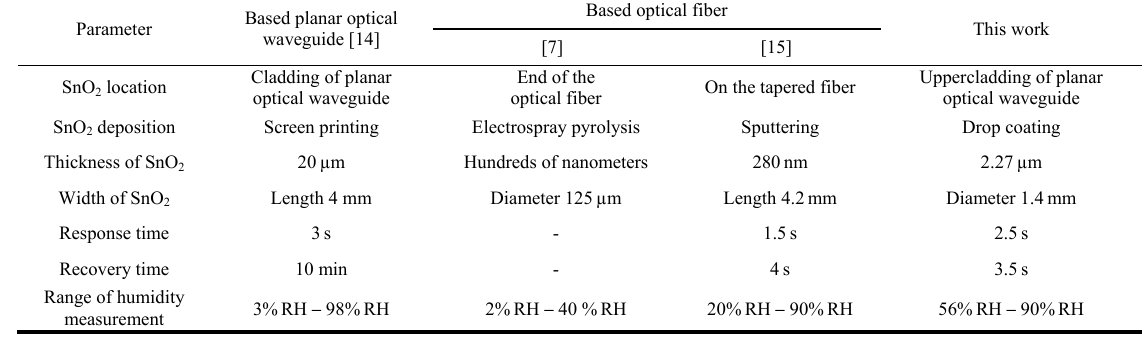
Table 1 Comparison between this work and previous work in all-optical humidity sensor with based SnO 2 nanoparticles.